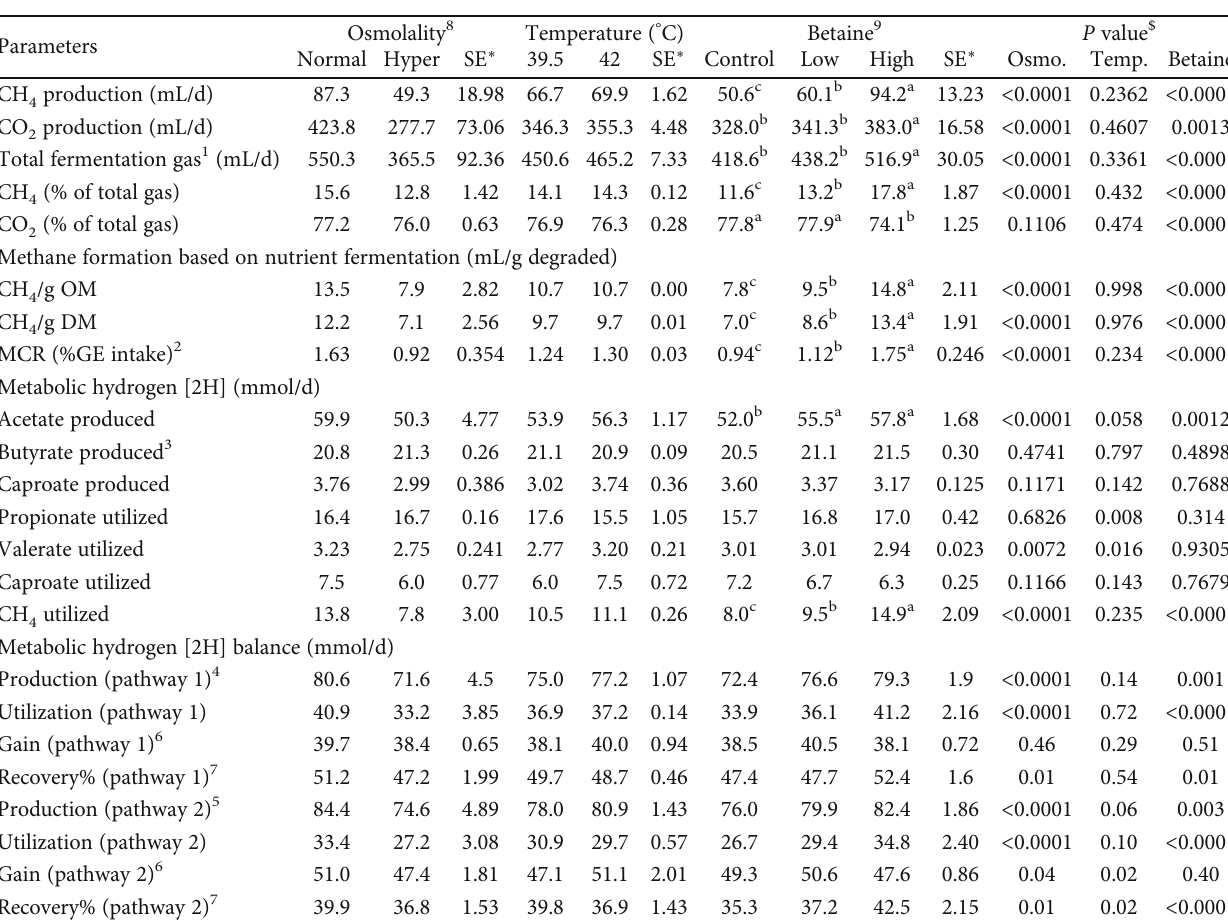
Table 2: Fermentation gas parameters and energy connected with methane.